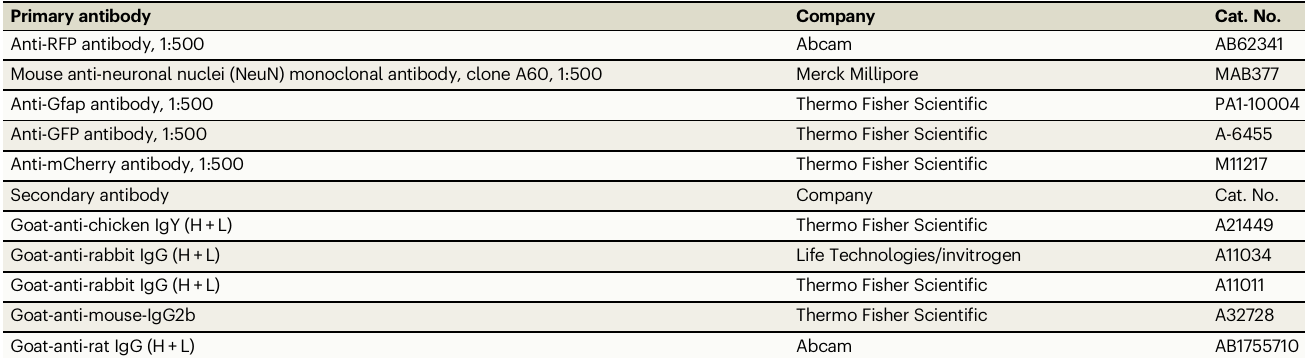
Table 2 | The list of antibodies used in this study Primary antibody Anti-RFP antibody,